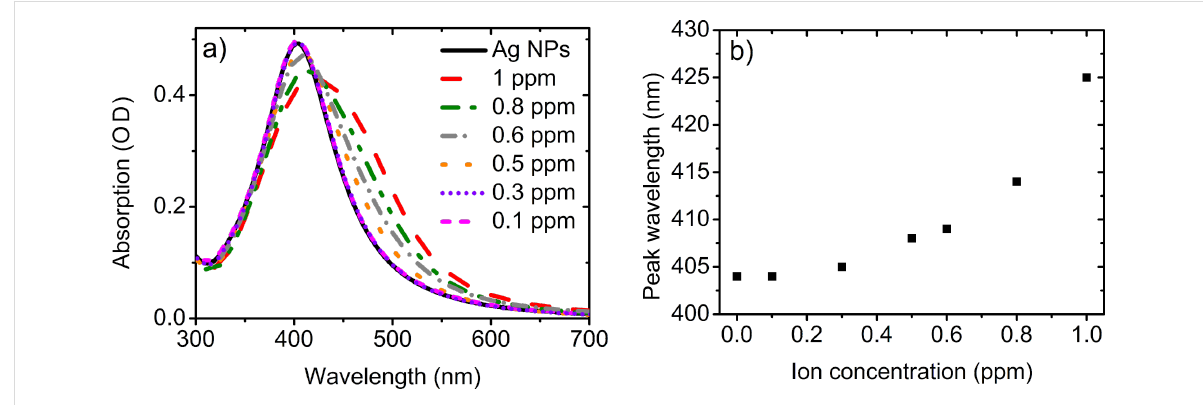
Figure 7: a) Absorption spectra of the AgNP-3MPS system (synthesis b) as a function of the Ni 2+ concentration. b) Peak absorption wavelength as a function of the ion concentration.